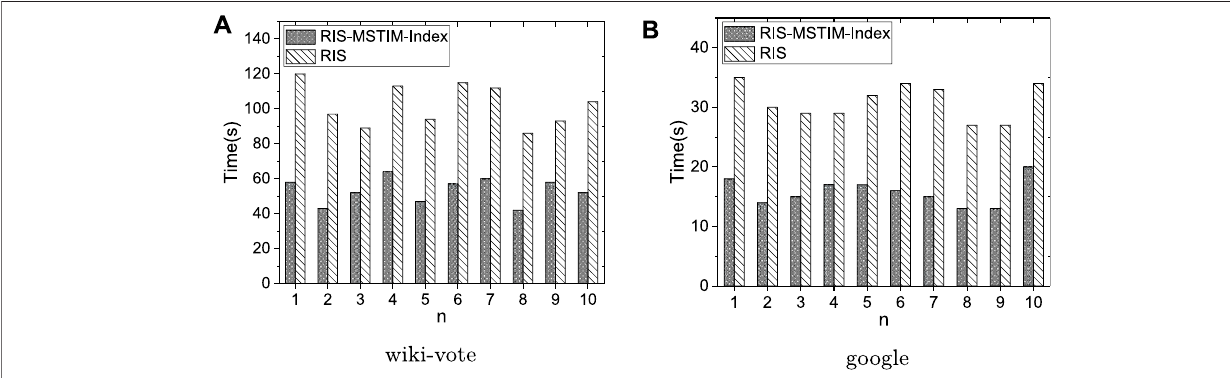
FIGURE 9 | The time costs of each query group over wiki-vote and google datasets.